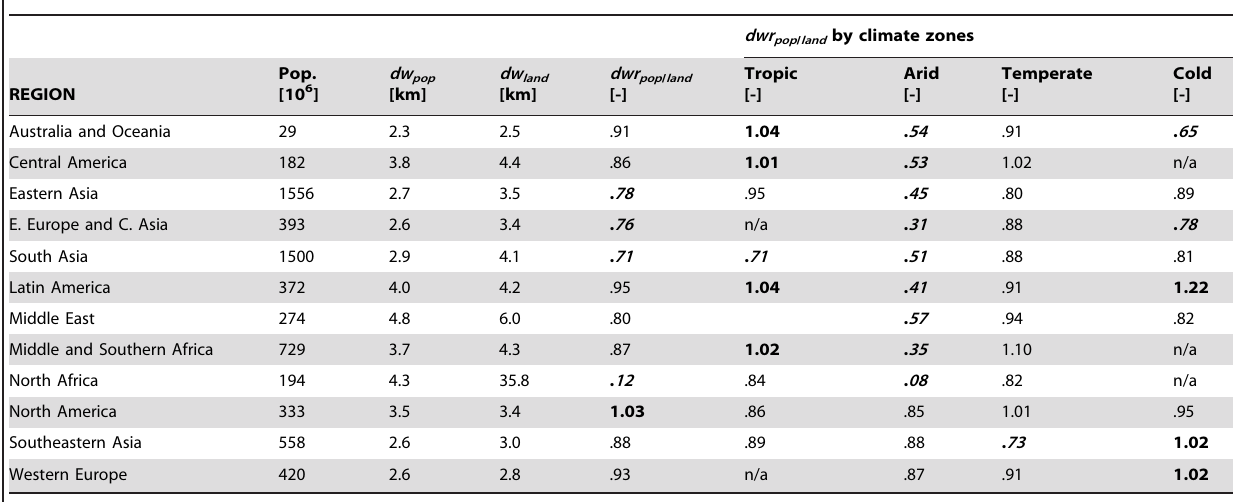
Table 4. Regional results for total population, population distance to water ( dw pop ), land distance to water ( dw land ), and ratio ( dwr pop / land ) of dw pop over dw land , for each region as a whole and by regional climate zones.